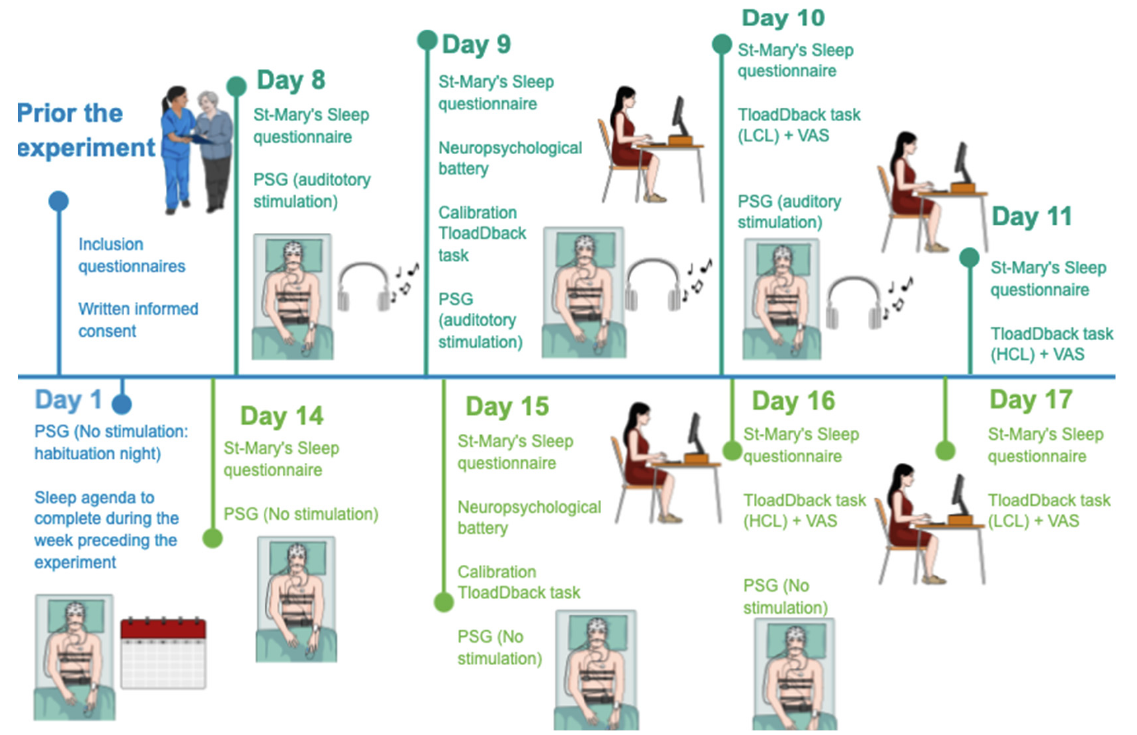
Figure 1. Experimental protocol. Note: PSG = Polysomnography. VAS = Visual Analogue Scales (fatigue, sleepiness, stress, and motivation). LCL = Low Cognitive Load Condition. HCL = High Cognitive Load Condition.